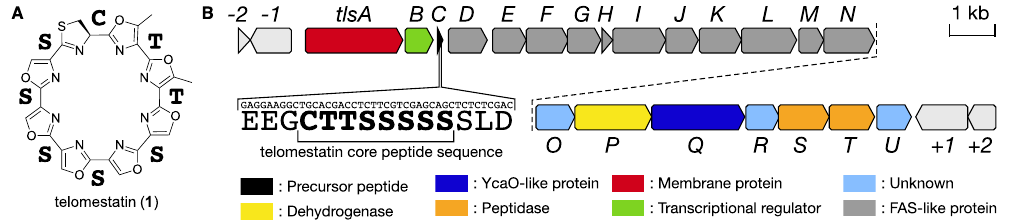
Figure 1. ( A ) The chemical structure of 1 and putative amino acid constitution from the structure. ( B ) Gene organization of 1 biosynthetic gene cluster found in S. anulatus 3533-SV4. Putative functions of each ORF in the 1 biosynthetic gene cluster are summarized in Table S1.